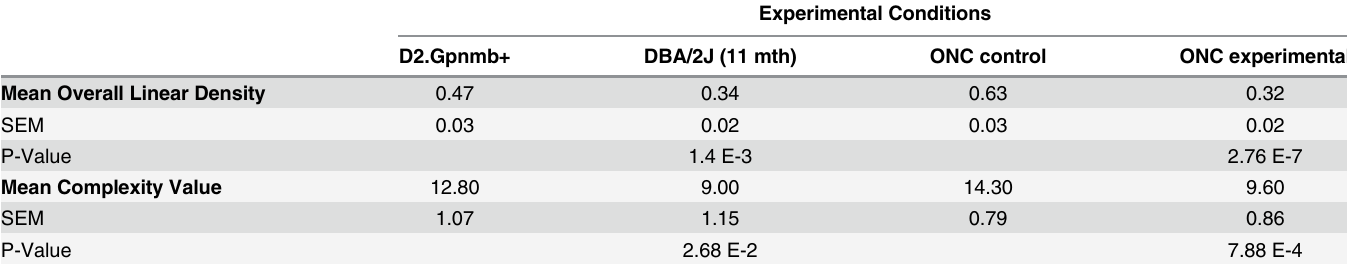
Table 1. Mean Overall Linear Density and Complexity Values across Experimental Conditions. Mean values for overall linear density and complexity are shown with associated standard errors of the mean (n = 10 cells for each condition). Comparisons between experimental conditions and corresponding controls are indicated by significance values generated via two-tailed T-tests.